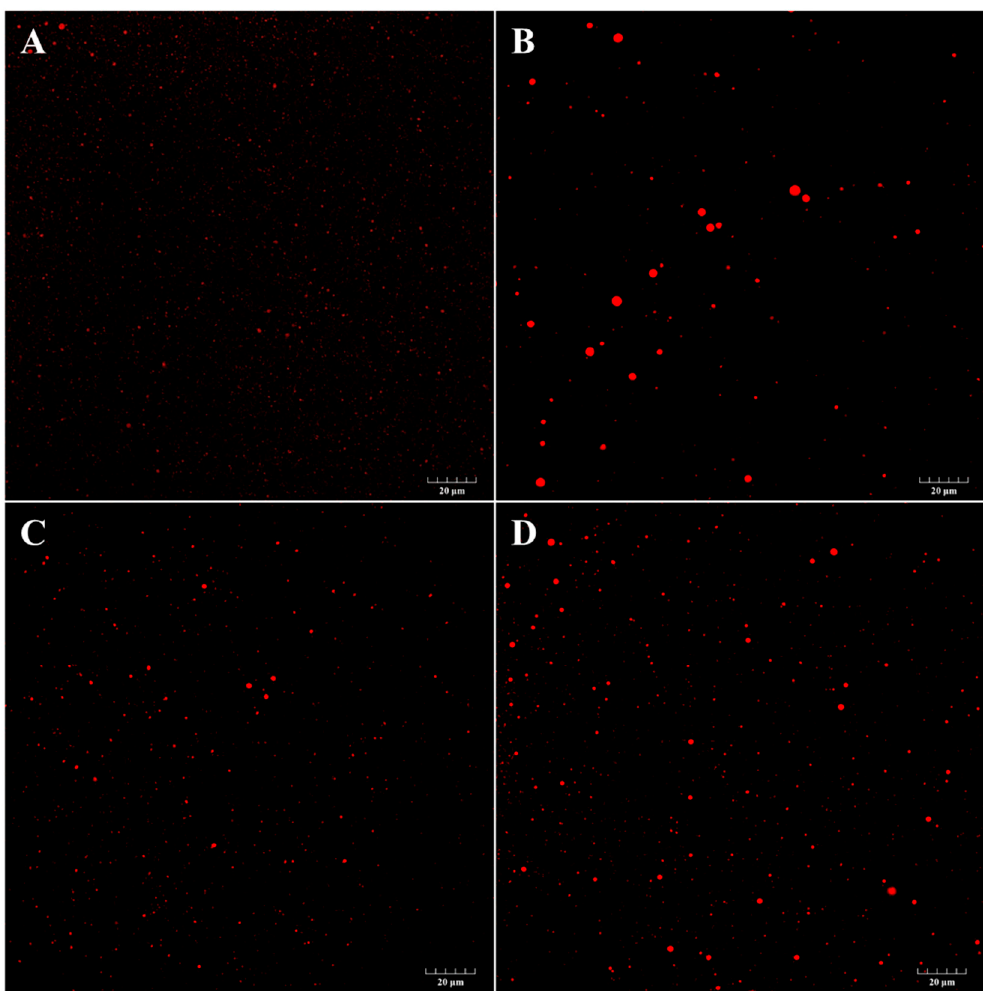
Figure 6. Laser scanning confocal micrographs of emulsions. The oil phase (red) was stained with Nile red excited at 541 nm. The scale bar is 20 μ m. ( A ) Control ‐ 0 days, ( B ) Control ‐ 25 days, ( C ) FSEY ‐ 25 days, and ( D ) TBHQ ‐ 25 days.